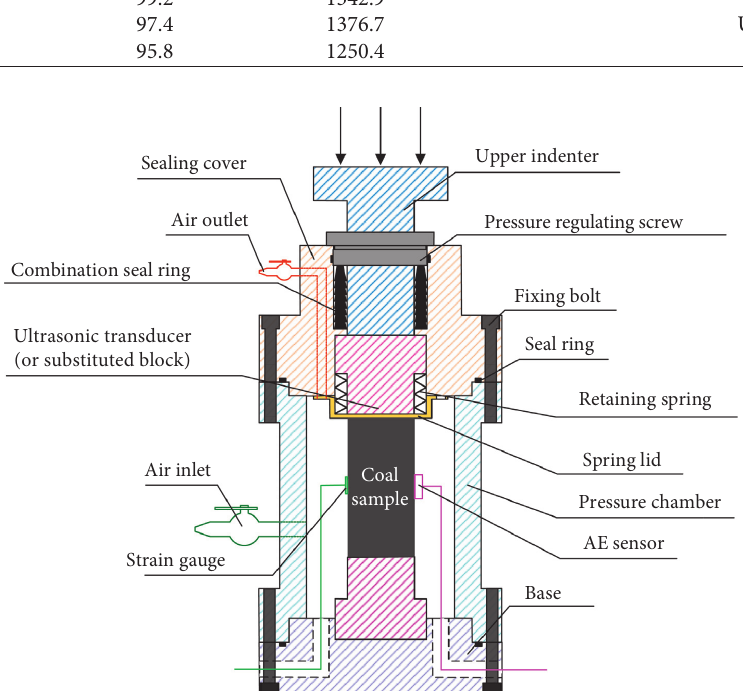
Figure 2: Schematic of the new gas-solid coupling loading device used in this study.